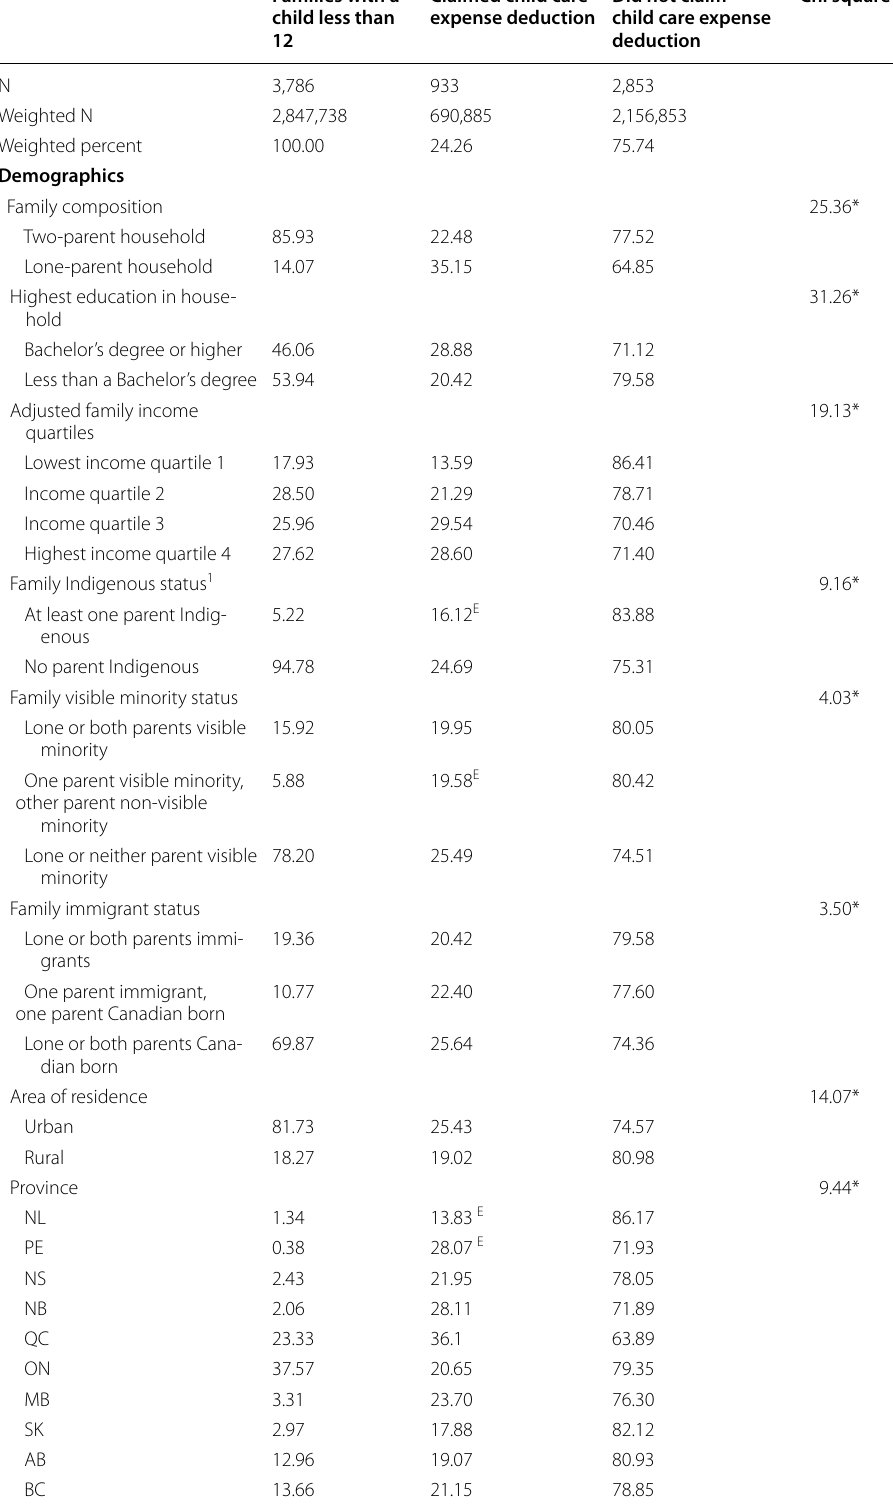
Table 1 Characteristics of families with at least one child less than 12 years old who did and did not claim the child care expense deduction Families with a child less